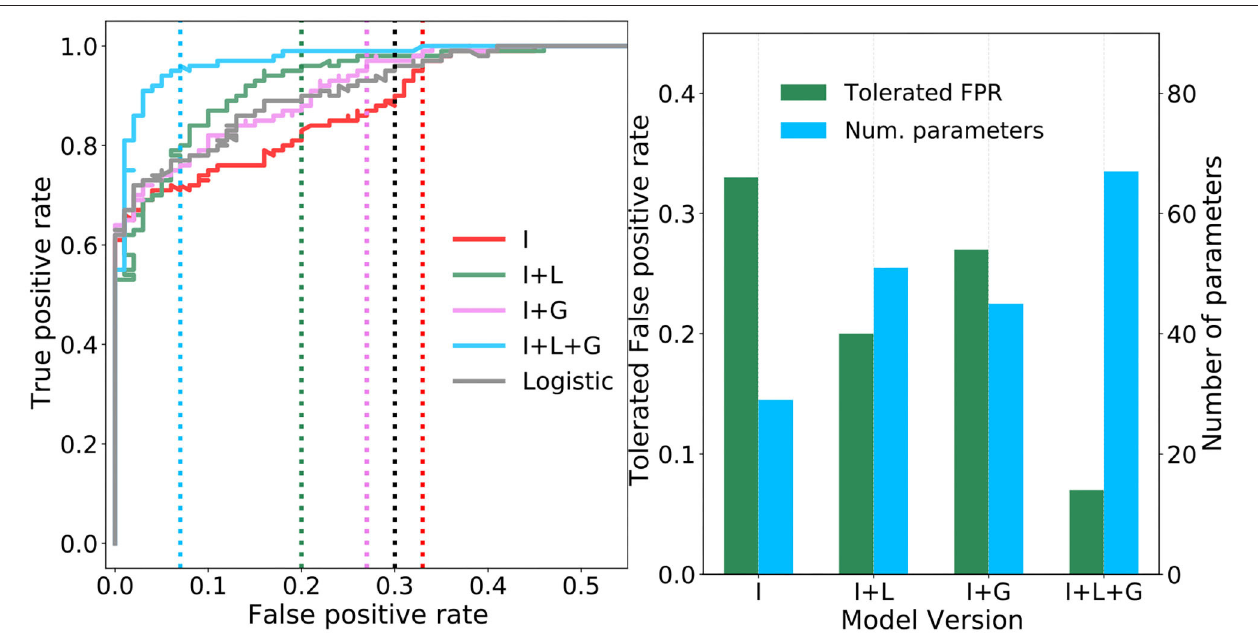
FIGURE 6 | Performance of the four ablated versions of the TAG model. (A) Four receiver operating characteristic (ROC) curves are plotted showing how the true and false positive rates vary as the probability threshold on the sigmoidal output jump neuron is increased. Vertical dashed lines show the tolerated false positive rate (FPR) for a minimum true positive rate of 0.95. (B) Pairs of bar plots for each ablated version of the TAG model show the tolerated FPR given a minimum TPR of 0.95 (green bars, left y-axis) and the number of parameters required by the model version (blue bars, right y-axis).